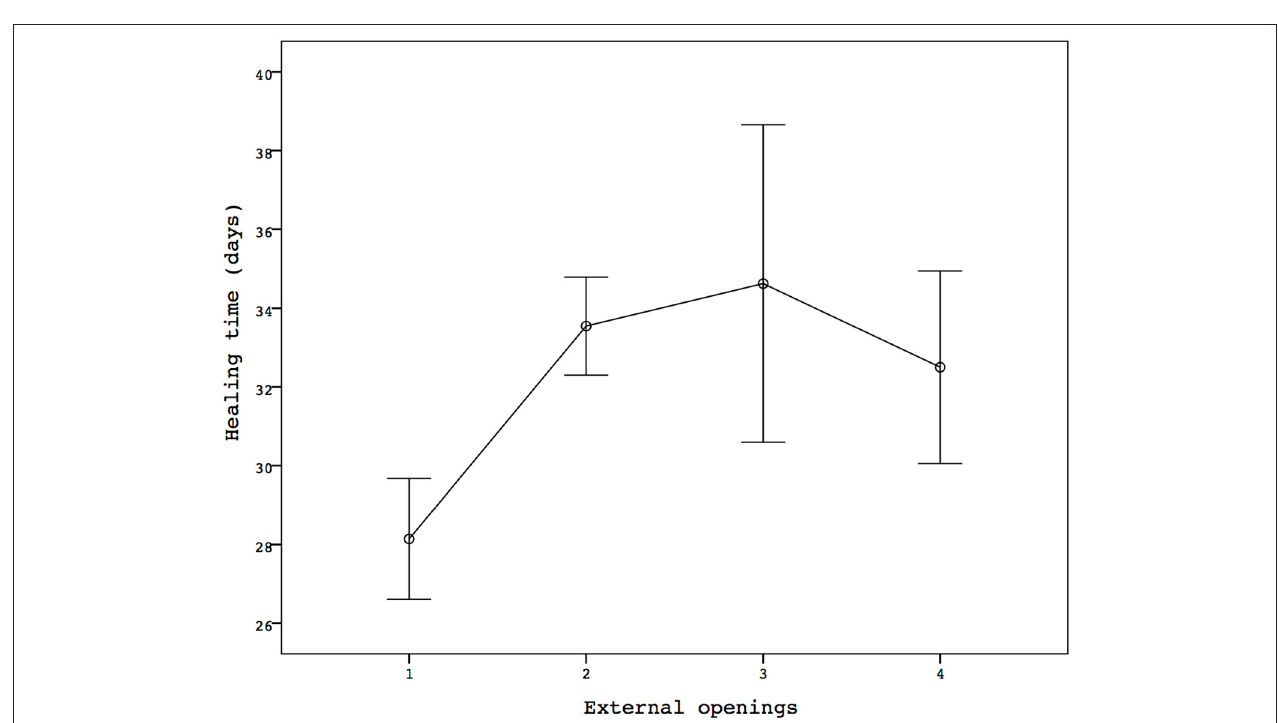
FIGURE 2 | Healing time related to the number of the external openings.